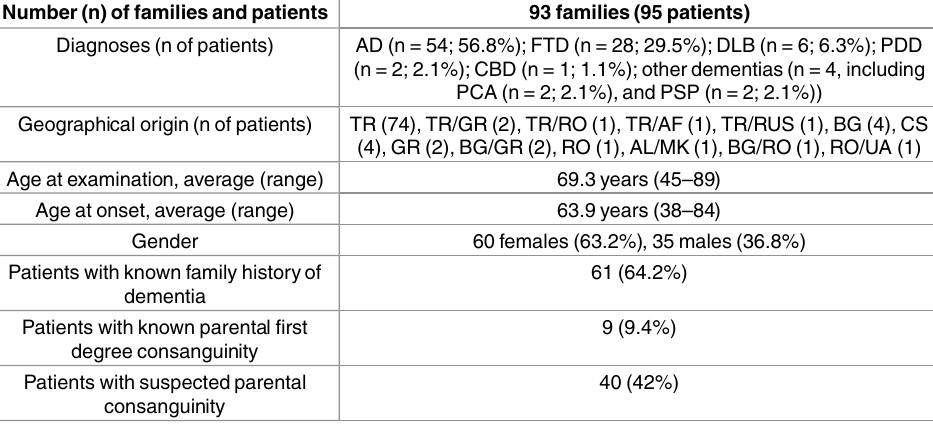
Table 1. Characteristicsof the cohortof dementia patients analysed for mutationsin MAPT , GRN and C9ORF72 . Number (n) of familiesand